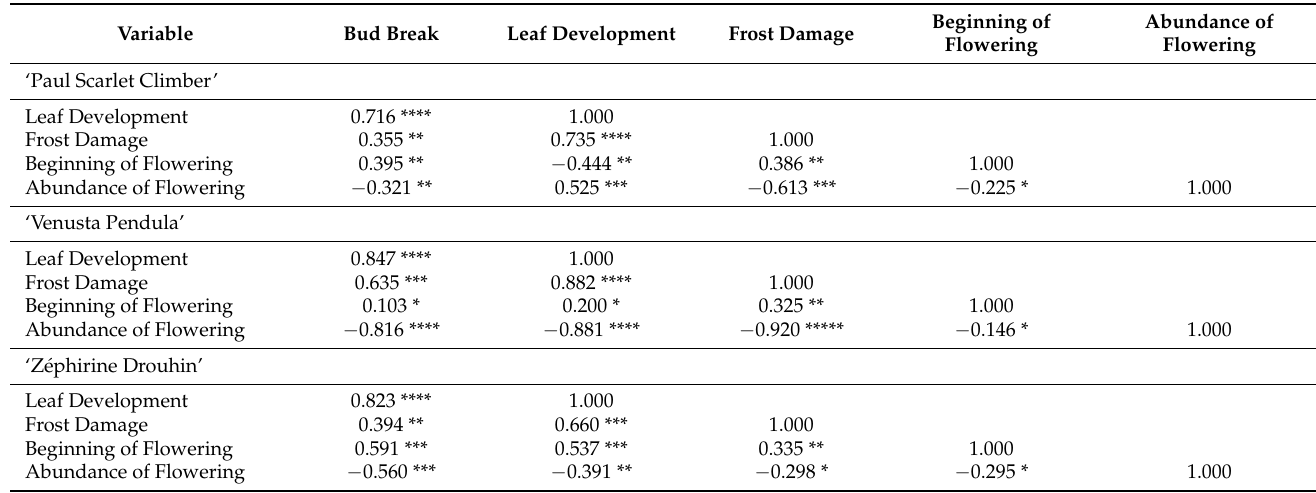
Table 13. Correlations matrices between frost damage, early phenology stages, and beginning and abundance of flowering in climber roses: ‘Paul Scarlet Climber’, ‘Venusta Pendula’, and ‘Z é phirine